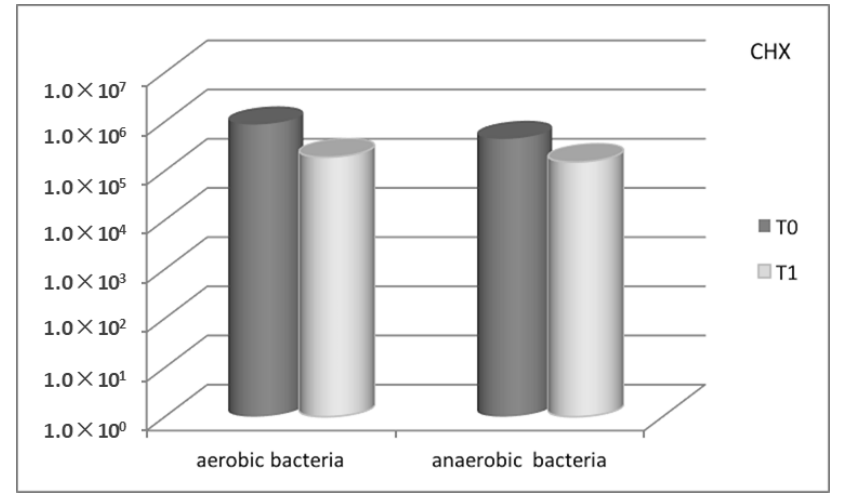
Figure 2 Figure 1. Total microbial count for Control-Group (CHX) between baseline (T0) and three-month follow-up (T1), for aerobic and anaerobic bacteria,